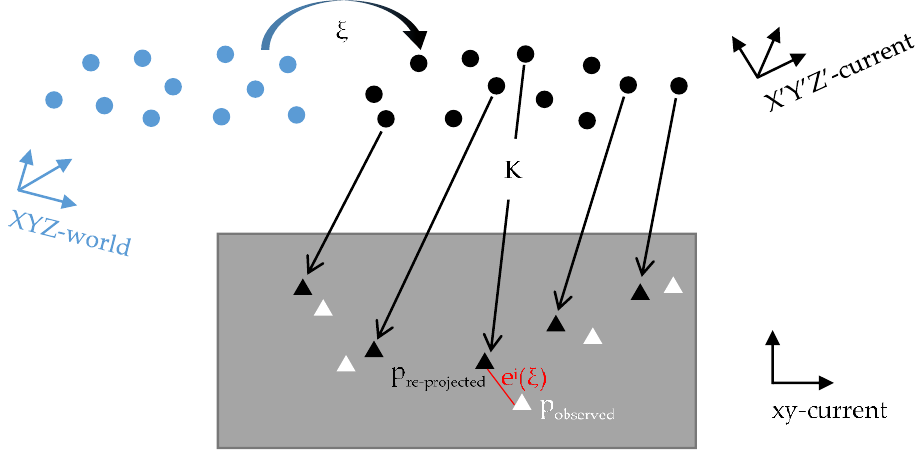
Figure 4. Process of building an error model of point features. The blue dots and black dots represent the world 3D map points and current 3D map points, respectively. The black triangles represent the re-projected 2D points and the white triangles represent the observed 2D points.